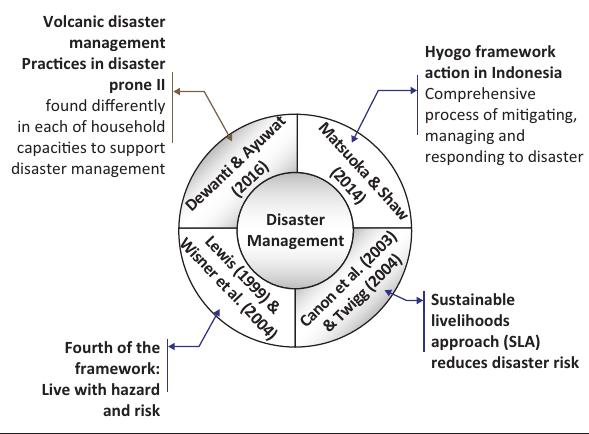
FIGURE 1: Theoretical framework based on meaning and perspective of disaster